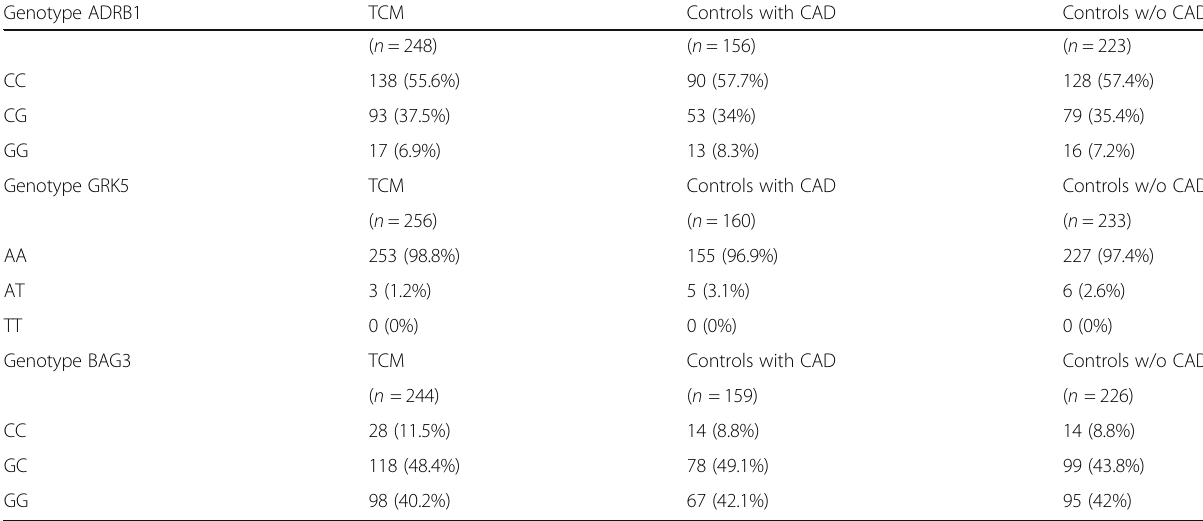
Table 2 Genotype distributions of ADRB1, GRK5 and BAG3 gene Genotype ADRB1 TCM